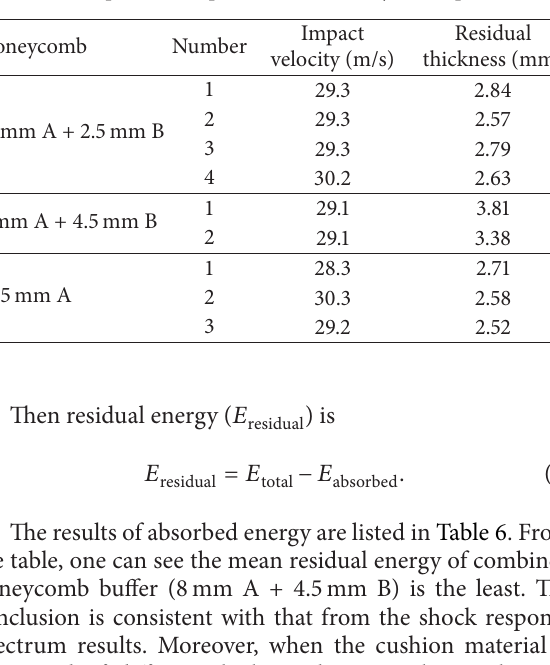
Table 5: Experimental parameters of honeycomb